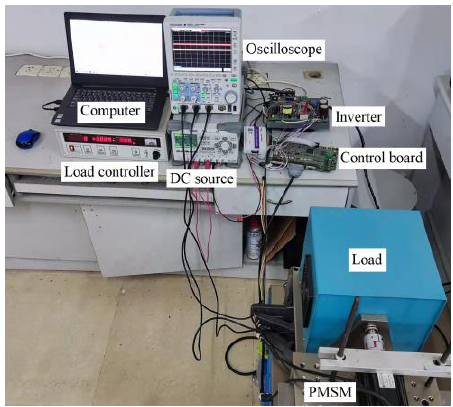
Figure 15. Experimental setup of the two-level fed PMSM drive.